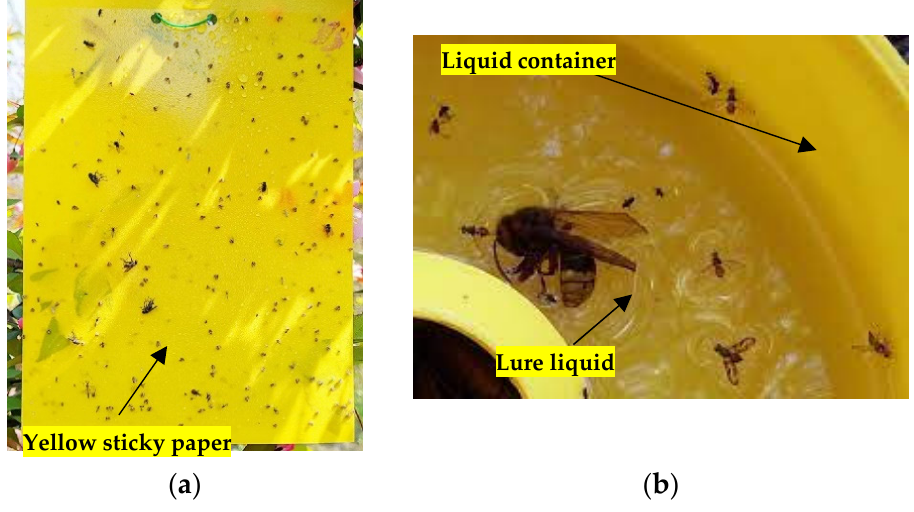
Figure 5. Trap images: ( a ) yellow sticky paper image; ( b ) liquid trap image.